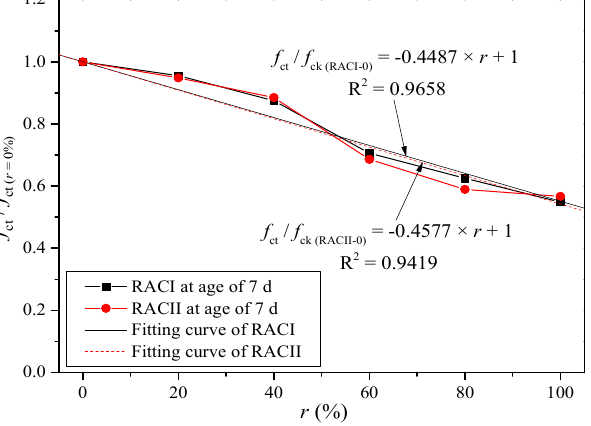
Figure 9. Fitting curve of coefficient β.